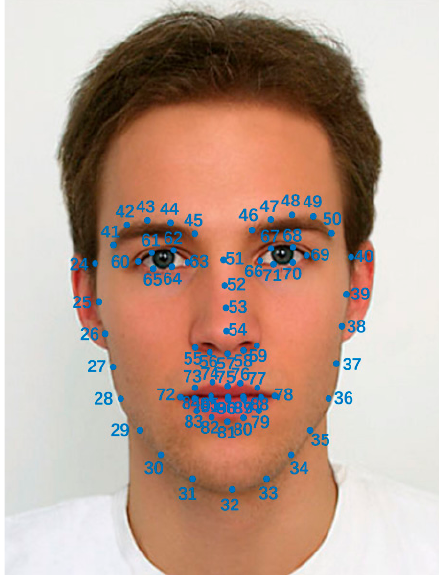
Figure 4. Face positioning with 68 points